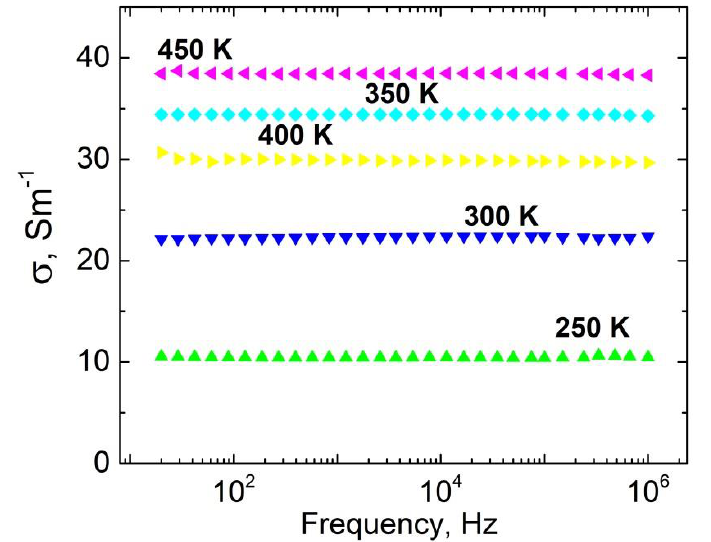
Figure 5. Frequency spectra of electrical conductivity for phosphate ceramics with 50 wt.% Ag nanoinclusions (size 80–100 nm).